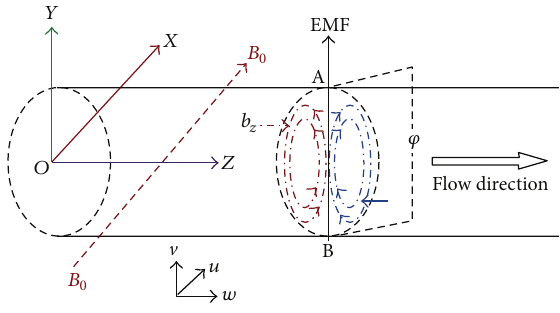
Figure 1: Physical sketch of the